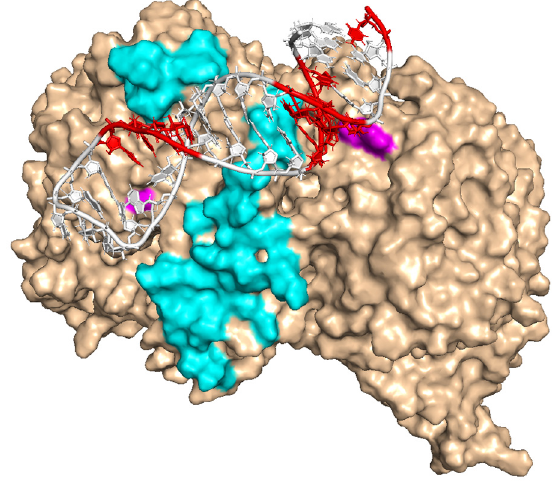
Figure 5. Predicted structure of E3 binding to hTfR dimer by molecular modeling. The TfR dimer is colored beige, with the Tf-binding domain highlighted in cyan, and murine mutation sites 396F and 507E are highlighted in magenta. E3 is colored white, with the putative binding bulge and loop region highlighted in red.